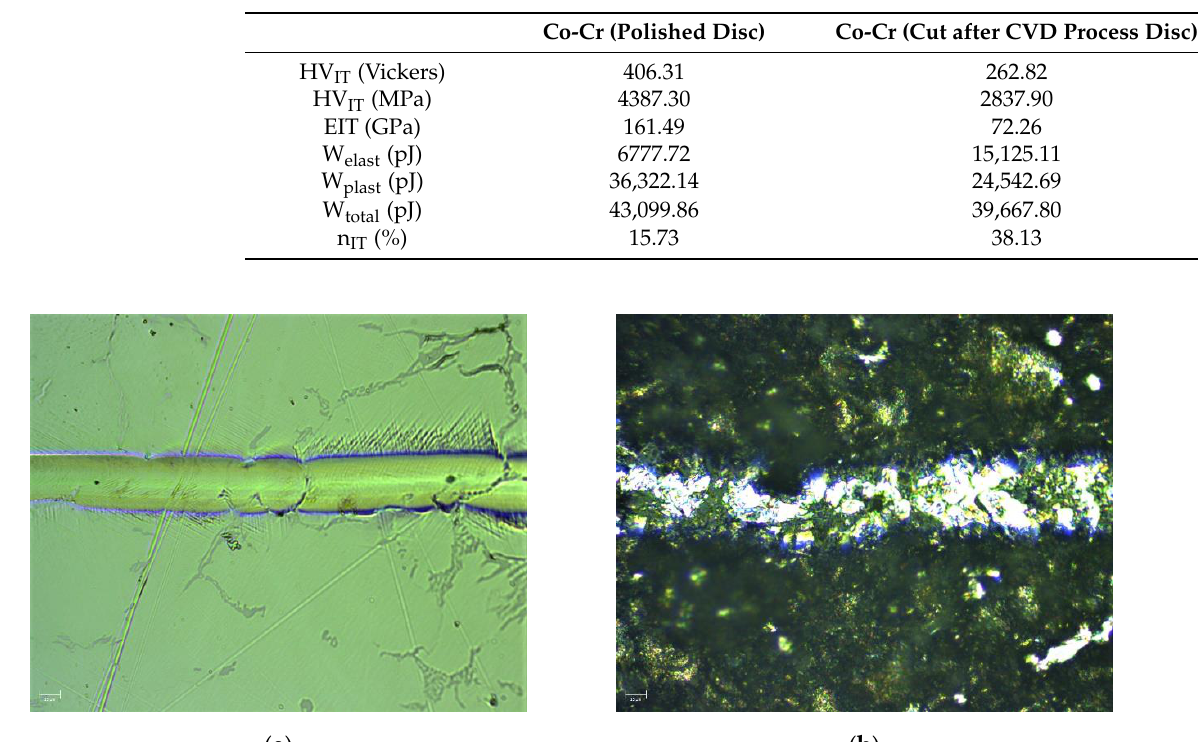
Figure 10. Microscopic image of the residual groove after a scratch test on polished ( a ) and unpolished ( b ) Co-Cr disc.